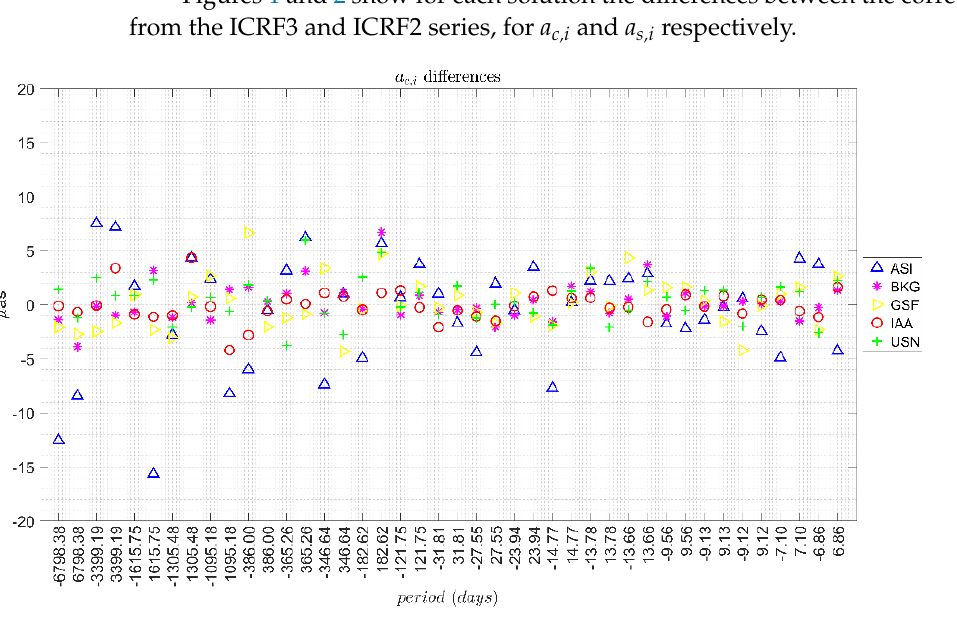
Figure 1. Differences in a c , i terms derived from the ICRF3 and ICRF2 series.